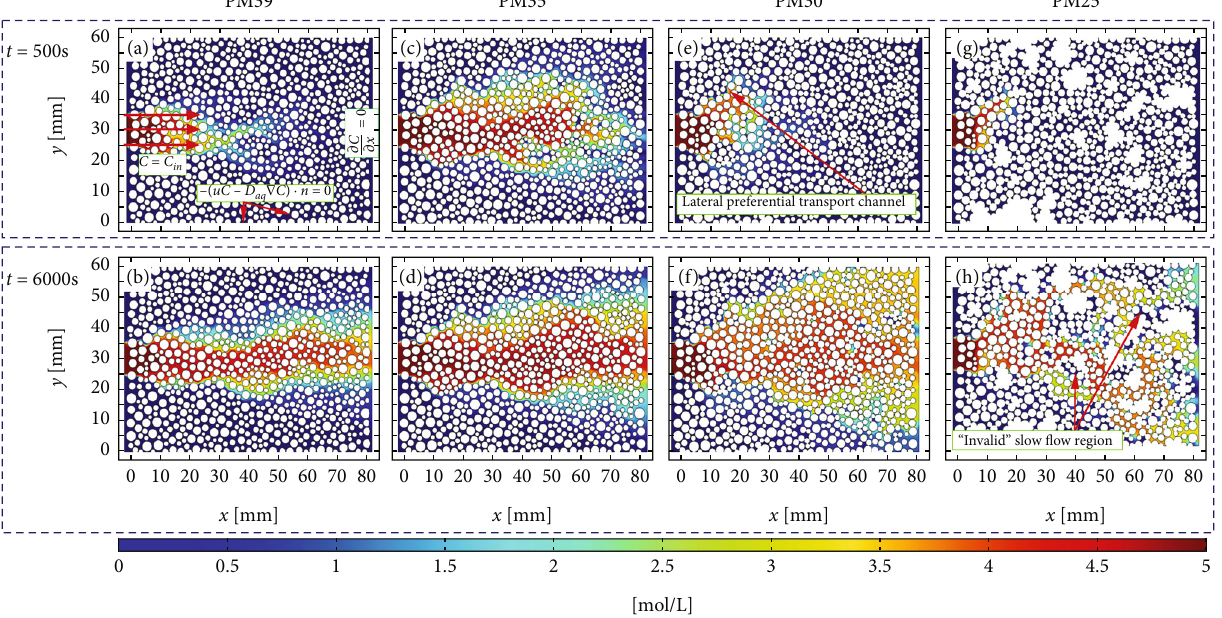
Figure 2: Migration patterns of the solute plumes in Group 1 porous media: PM39 (a, b); PM35 (c, d); PM30 (e, f); PM25 (g, h) at 500 and 6000s. Note: in the fi gure, PM39, PM35, PM30, and PM25 represent media with porosities of 0.39, 0.35, 0.30, and 0.25, respectively. The boundary conditions of the solute transport model indicated for PM39 were also applied to the other